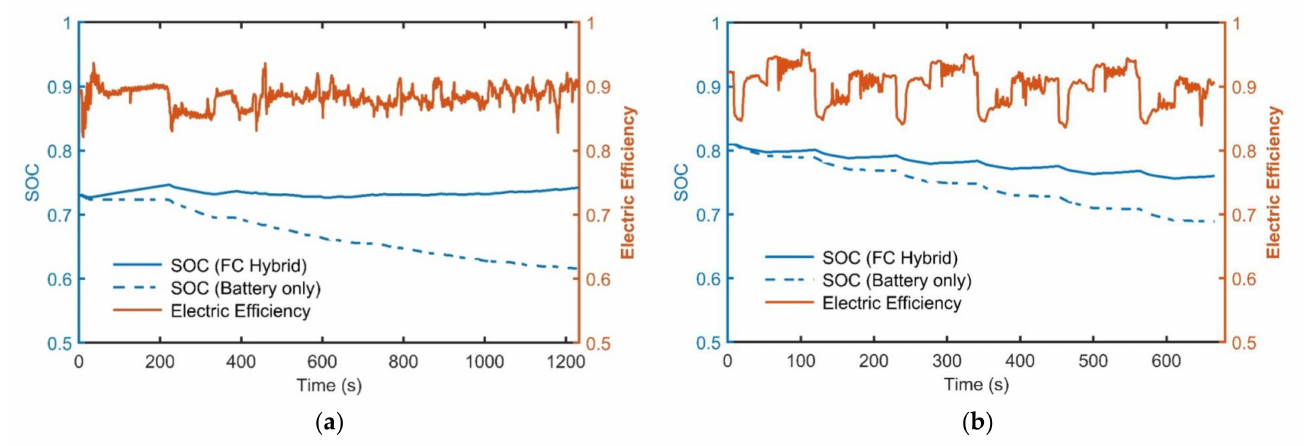
Figure 6. Electric efficiency of the fuel cell stacks under driving cycles: ( a ) Shanghainese urban driving cycle; ( b ) Chinese standard driving